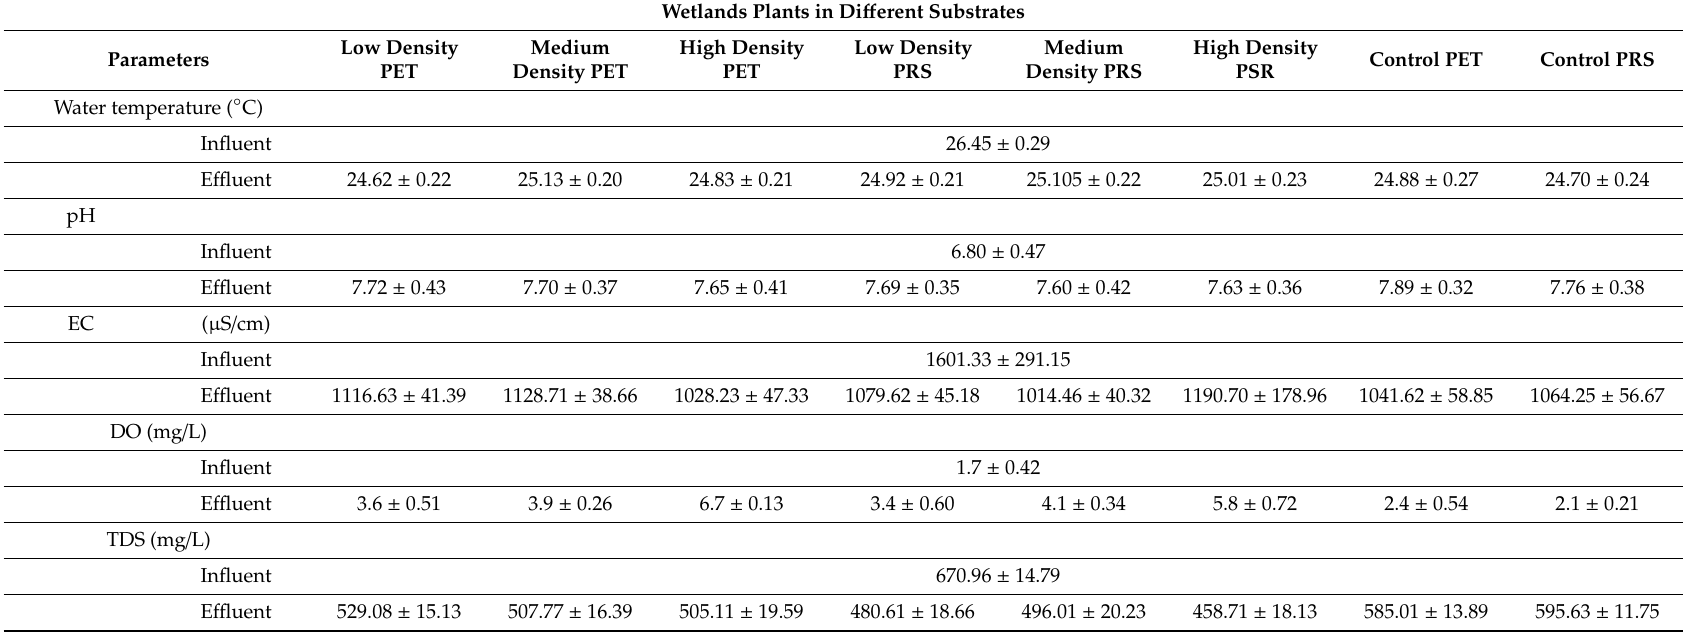
Table 1. Water quality parameters in influent and enfluent in